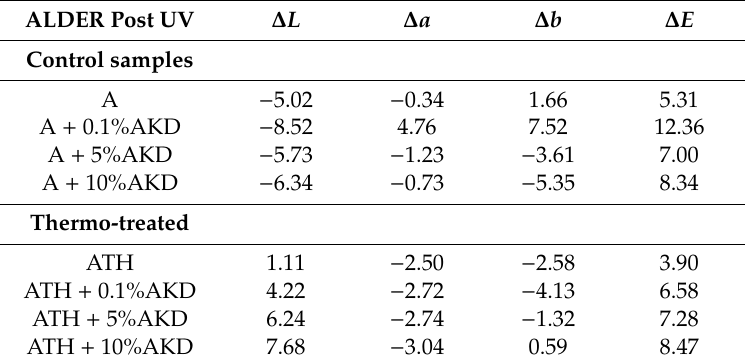
Table 3. The colour change (mean value) for both the untreated and treated alder after the weathering